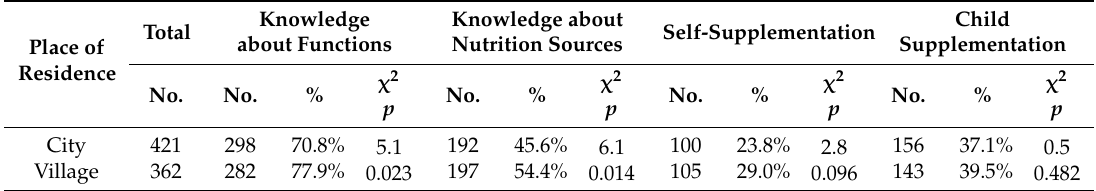
Table 4. The influence of place of residence on knowledge and supplementation of vitamin D ( n = 783) ( p = 0.05).